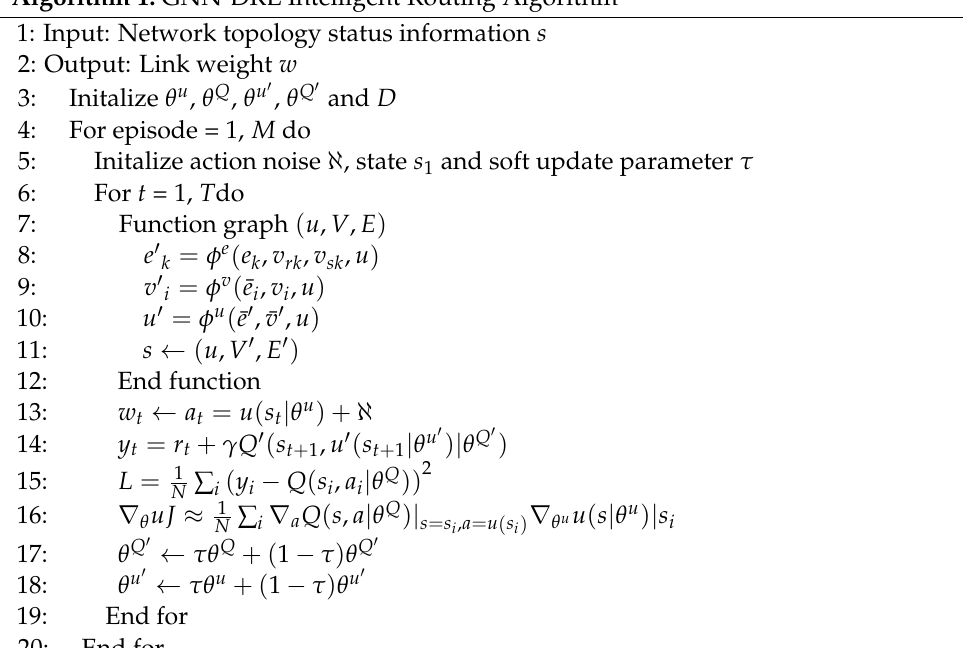
Algorithm 1: GNN-DRL Intelligent Routing